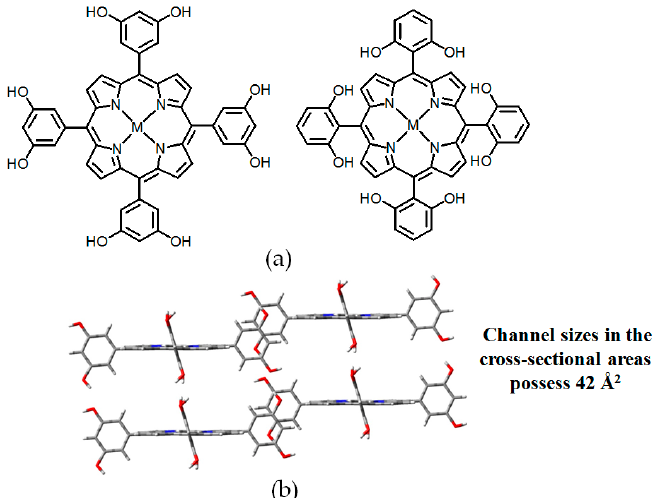
Figure 3. ( a ) Structures of building motifs of H1a – 1f (M = 2H, Zn(II), or Mn(III)); ( b ) Top view of the crystalline packing structure of H1a (CH 3 COOC 2 H 5 are omitted for clarity).